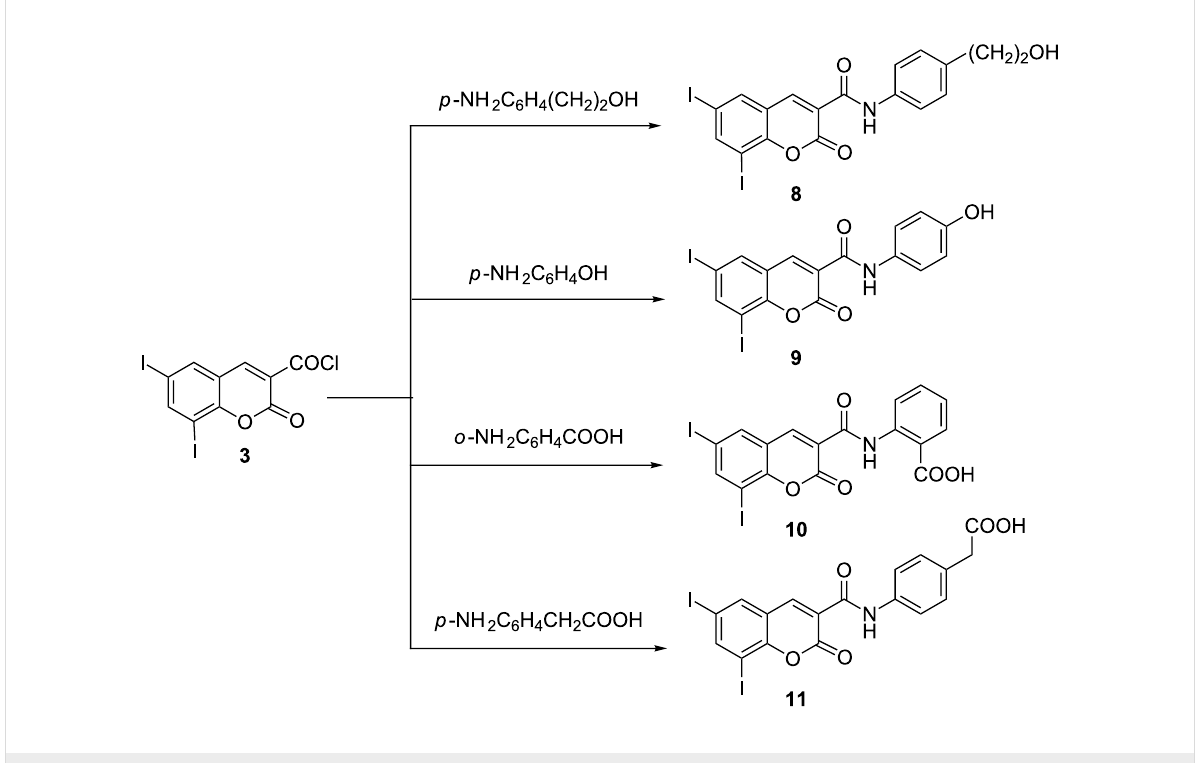
Scheme 3: Synthesis of 6,8-diiodocoumarin-3- N -carboxamide derivatives 8 – 11 .